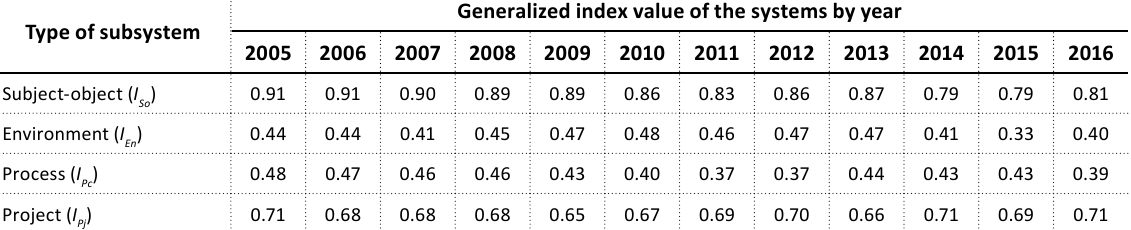
Table 3. Index values of machine-building enterprises subsystems for the 2005–2016 period (generalized by the group of